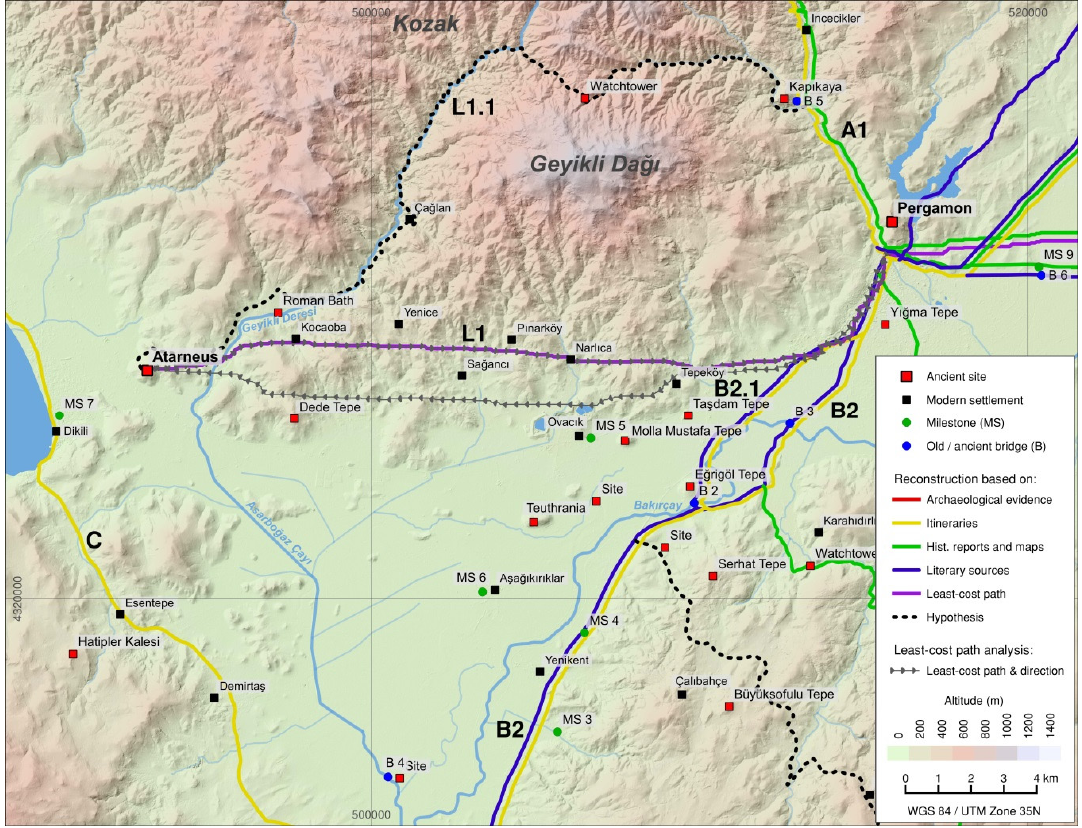
Figure 23. Calculated least-cost paths and reconstructed routes between Atarneus and Pergamon.